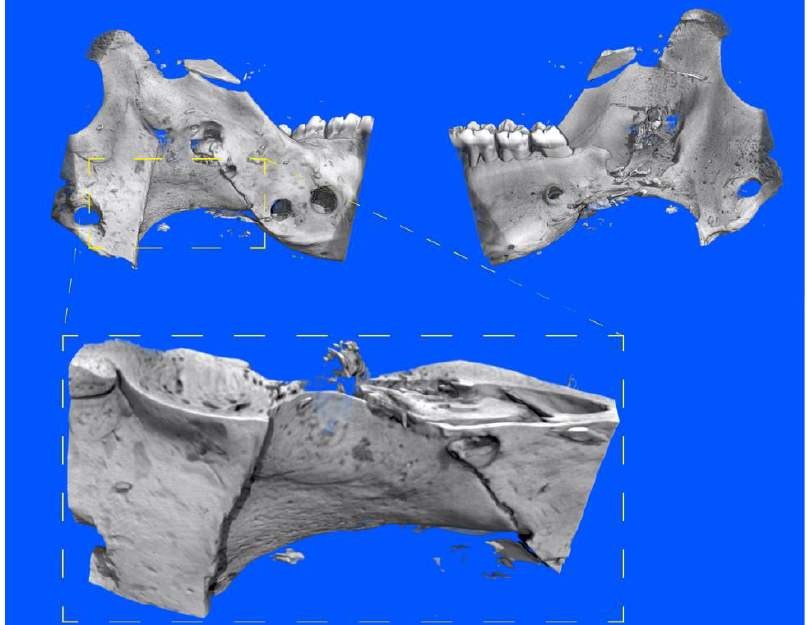
Figure 3. Three-dimensional representation of the distracted jaw generated from tomography data before decalcification, illustrating bone formation and the location of the holes used for the distractor screws.